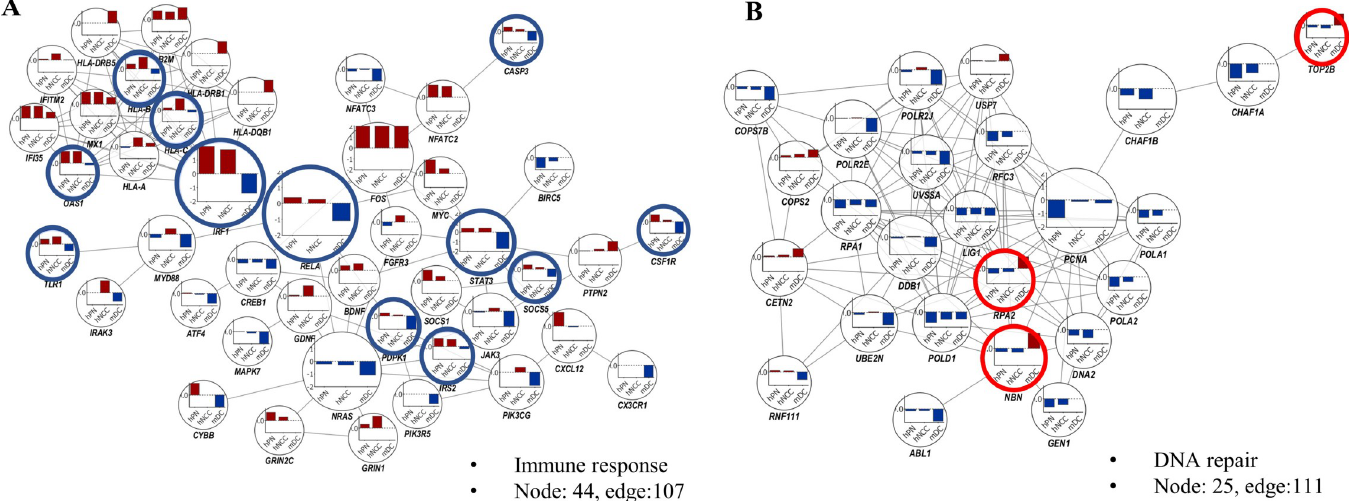
Fig 4. Comparative subnetwork with DEGs and fold-changes in hPNs, hNCCs, and mDCs. (A) The 107 protein interactions of 44 DEGs in cytokine-mediated signaling pathway. (B) The 111 protein interactions of 25 DEGs in DNA repair system. The bar charts in node show the fold-changes in hPNs (left bar), hNCCs (middle bar), and mDCs (right bar) infected with ZIKV. Fold-changes were calculated using log 2 (fold-change). Red circle: genes that are upregulated in mDCs as opposed to hPNs and hNCCs; blue circle: genes that are downregulated in mDCs as opposed to hPNs and hNCCs.